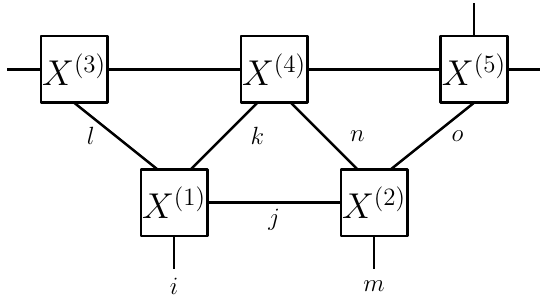
Figure 1 . An example of a general random tensor